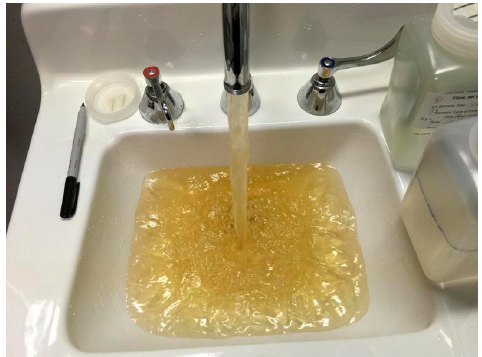
Figure 4. Tap water in a Flint hospital on 16 October 2015 Credit: Flintwaterstudy.org (accessed on 20 February 2021).